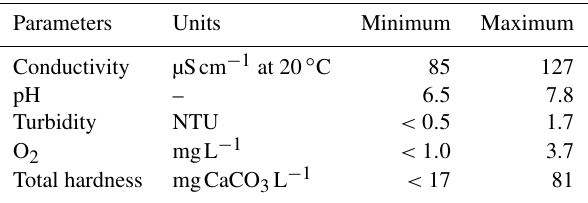
Table 1. Main physical and chemical characteristics of the water used in the soil flume experiments (Águas de Coimbra, 2016).